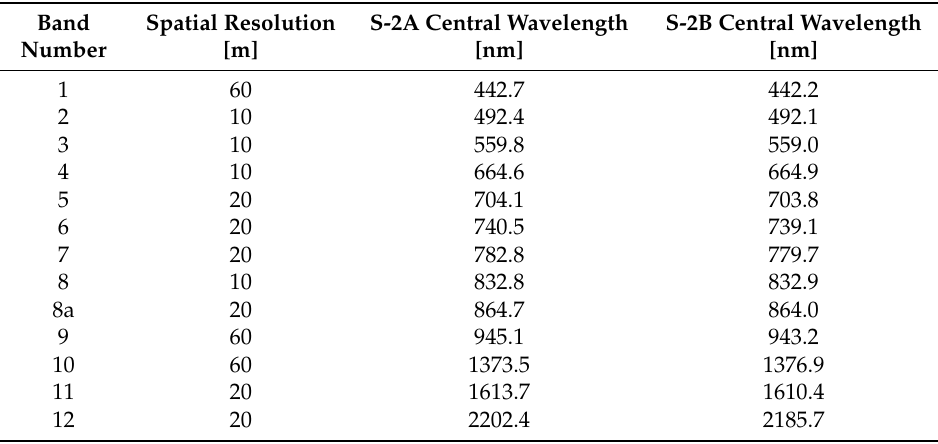
Table 1. Spatial resolution and central wavelength of Sentinel-2A and -2B spectral bands.